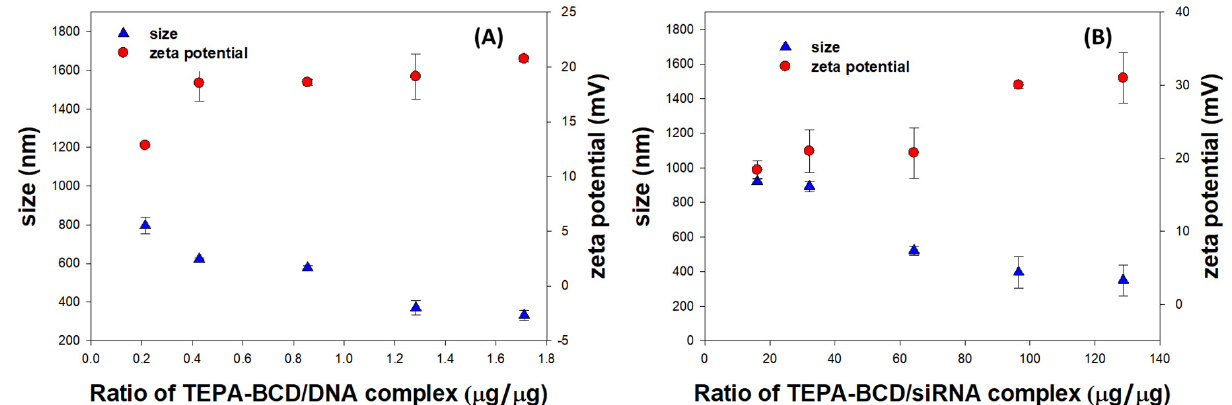
Figure 3. The size and zeta potential of TEPA-BCD/plasmid DNA ( A ) and TEPA-BCD/siRNA polyplexes ( B ) at various carrier/drug ratios using Zetasizer. In 100 µ L solution, TEPA-BCD amounts ranged from 0.21 to 1.71 µ g and the fixed amounts of plasmid DNA and siRNA were 1 µ g and 13.3 ng, respectively. Error bars represent the standard deviation (n =